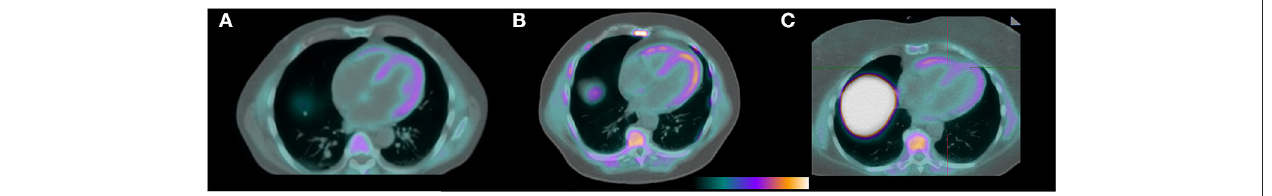
FIGURE 1 | F18-florbetapir PET/CT images demonstrating identifiable myocardial uptake of radiotracer in the patient with confirmed cardiac amyloidosis by technetium PYP ( A , mean myocardial SUV 3.3), a patient with light chain MGUS and a potential for having cardiac AL amyloidosis ( B , mean myocardial SUV 2.7), and a control patient with a negative tenosynovial biopsy for amyloidosis at the time of carpal tunnel release surgery ( C , mean myocardial SUV 2.0).